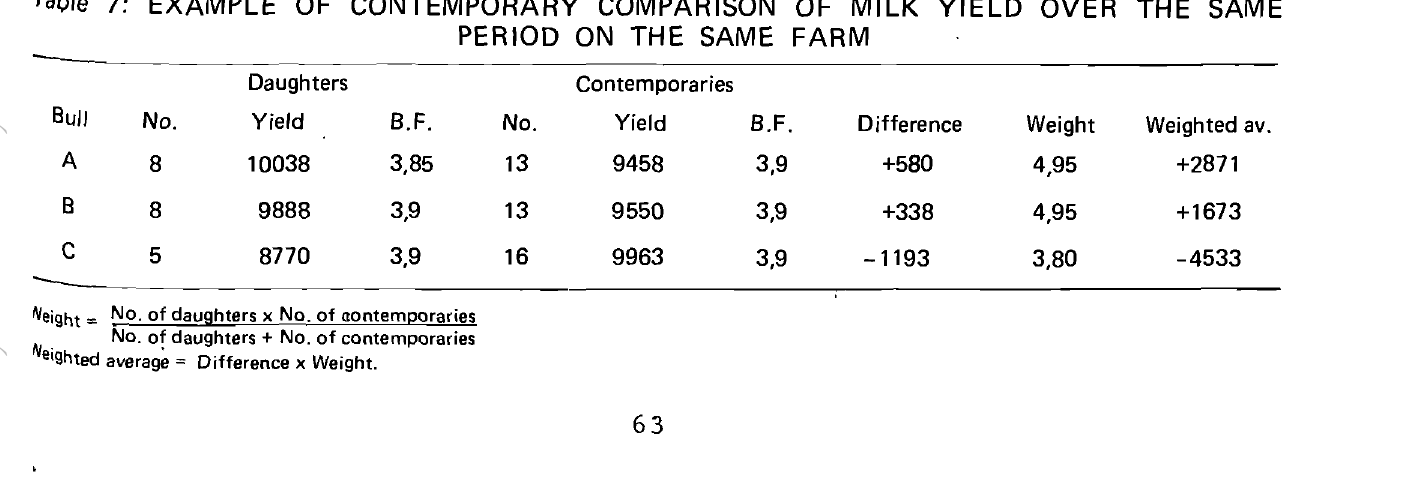
Table 7: EXAMPLE OF CONTEMPORARY COMPARISON OF MILK YIELD OVER THE SAME PERIOD ON THE SAME